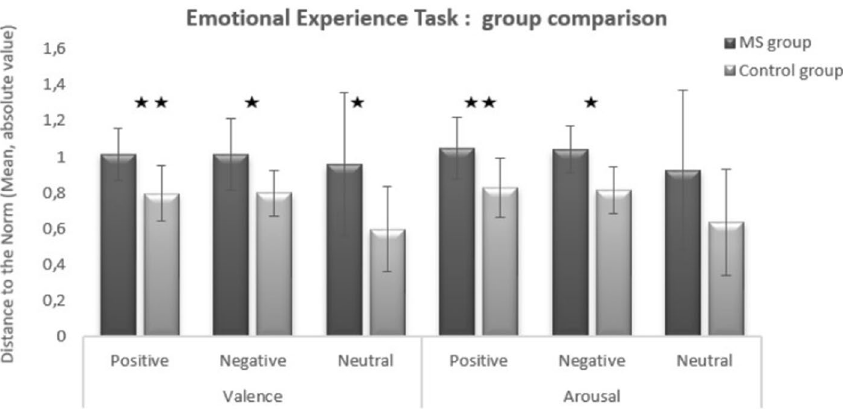
Figure 3. Dispersion of the subjective evaluation of emotional experience for positive, negative, and neutral IAPS pictures: comparison of MS group and control group scores for valence and arousal. *Significant difference at p < 0.05; **Significant difference at p <